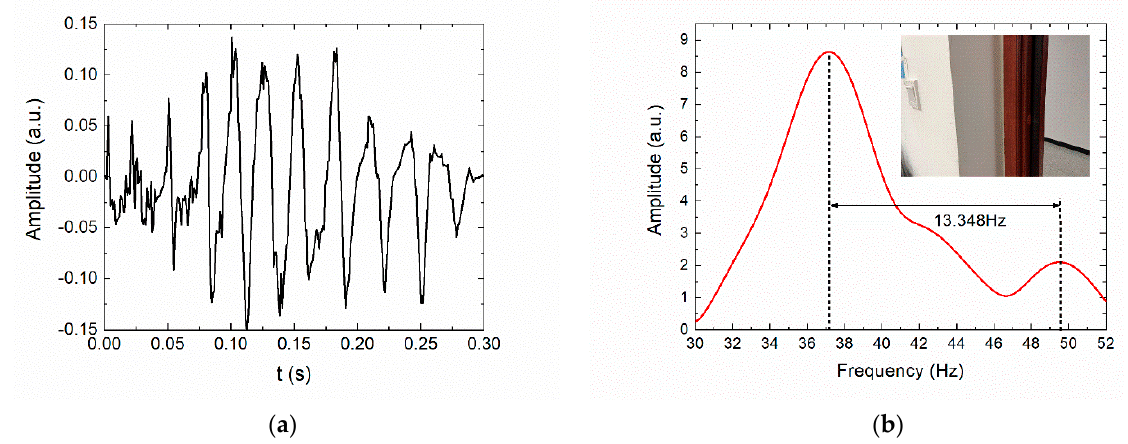
Figure 5. ( a ) The IF signal diagram after detecting a wall. ( b ) The spectrum diagram of the IF signal obtained by the CZT algorithm.